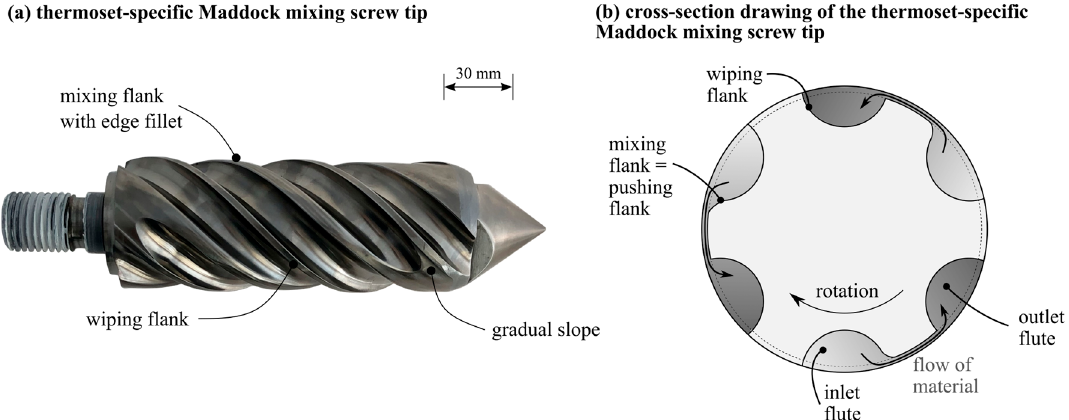
Figure 3. Thermoset-specific Maddock mixing element image ( a ) and cross section drawing ( b ).